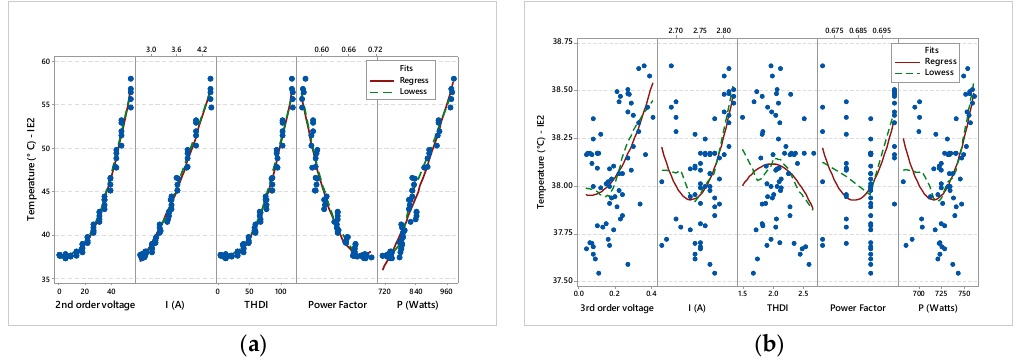
Figure 13. Temperature regression versus motor input parameters for IE2 class SCIM with voltage distortion of ( a ) 2nd harmonic voltage distortion; ( b ) 3rd harmonic voltage distortion.